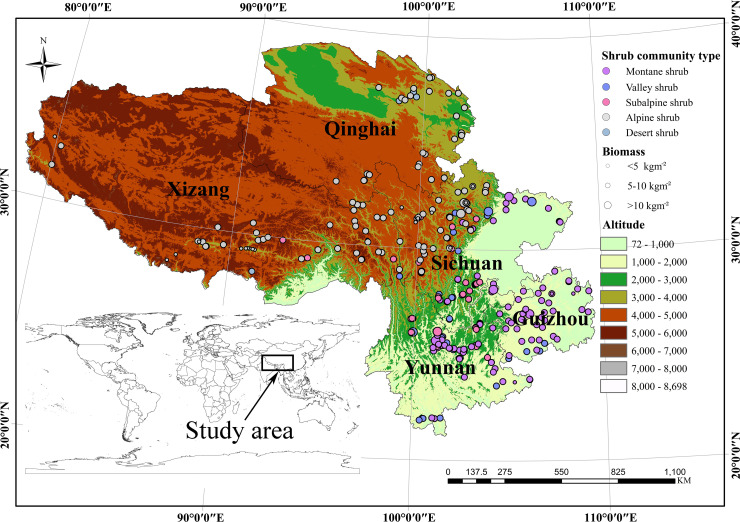
Study area, sampling sites, shrub community type and the spatial distribution of total biomass (TB) at community level of mountainous shrubs in Southwest China.